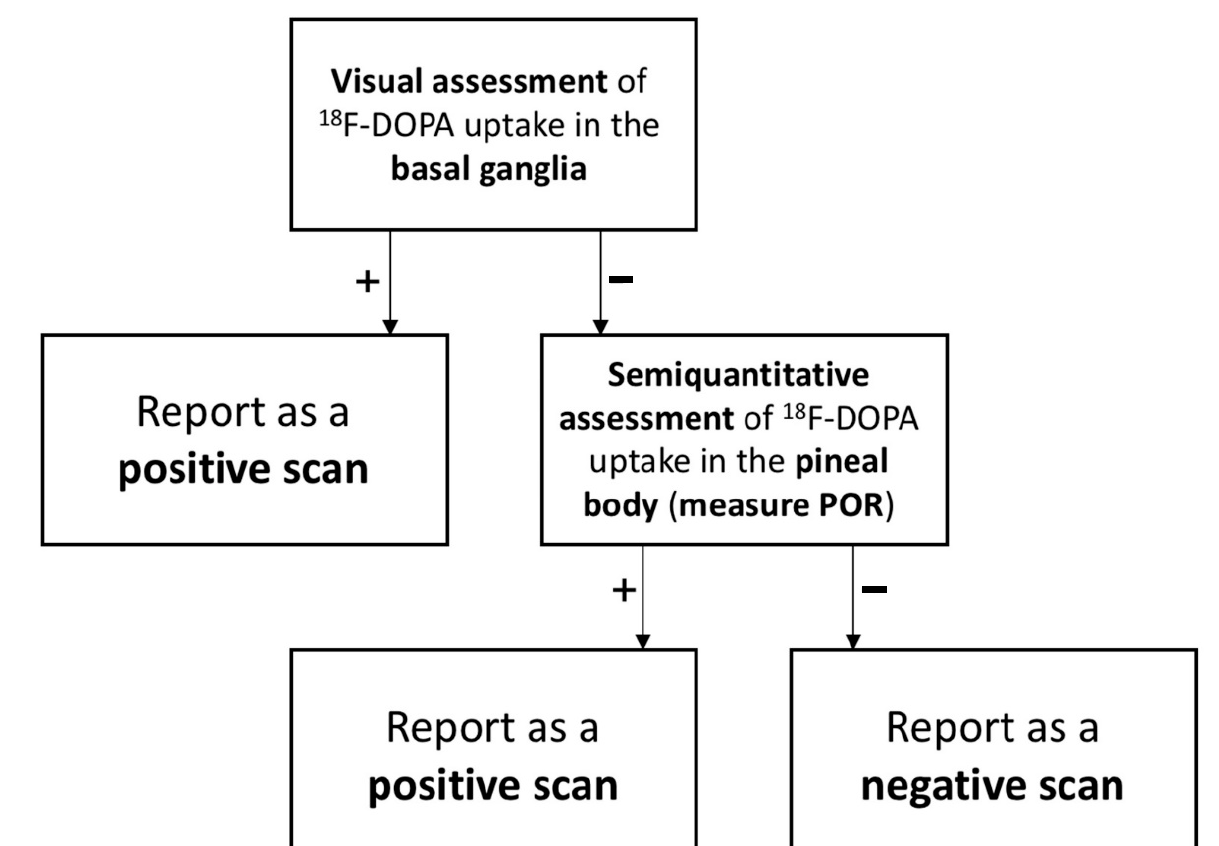
Figure 3. Our proposed algorithm for nigrostriatal dysfunction identi fi cation on 18 F-DOPA PET/CT.